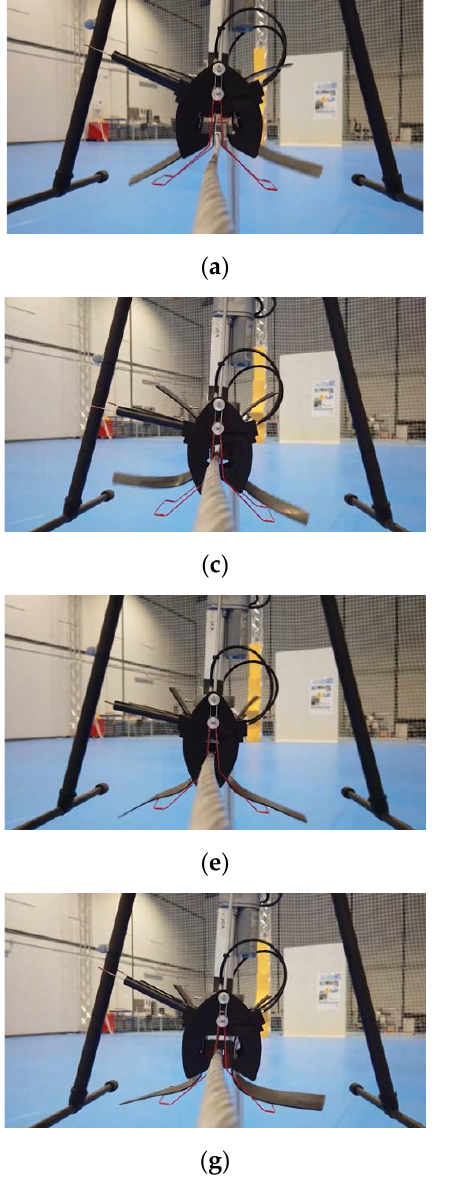
Table 1. The timing of the clip installation process.